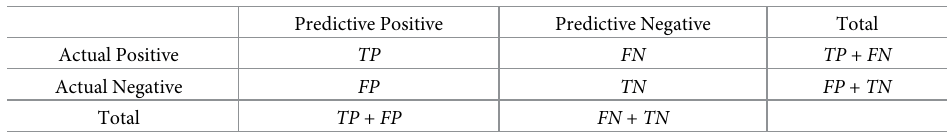
Table 7. Confusion